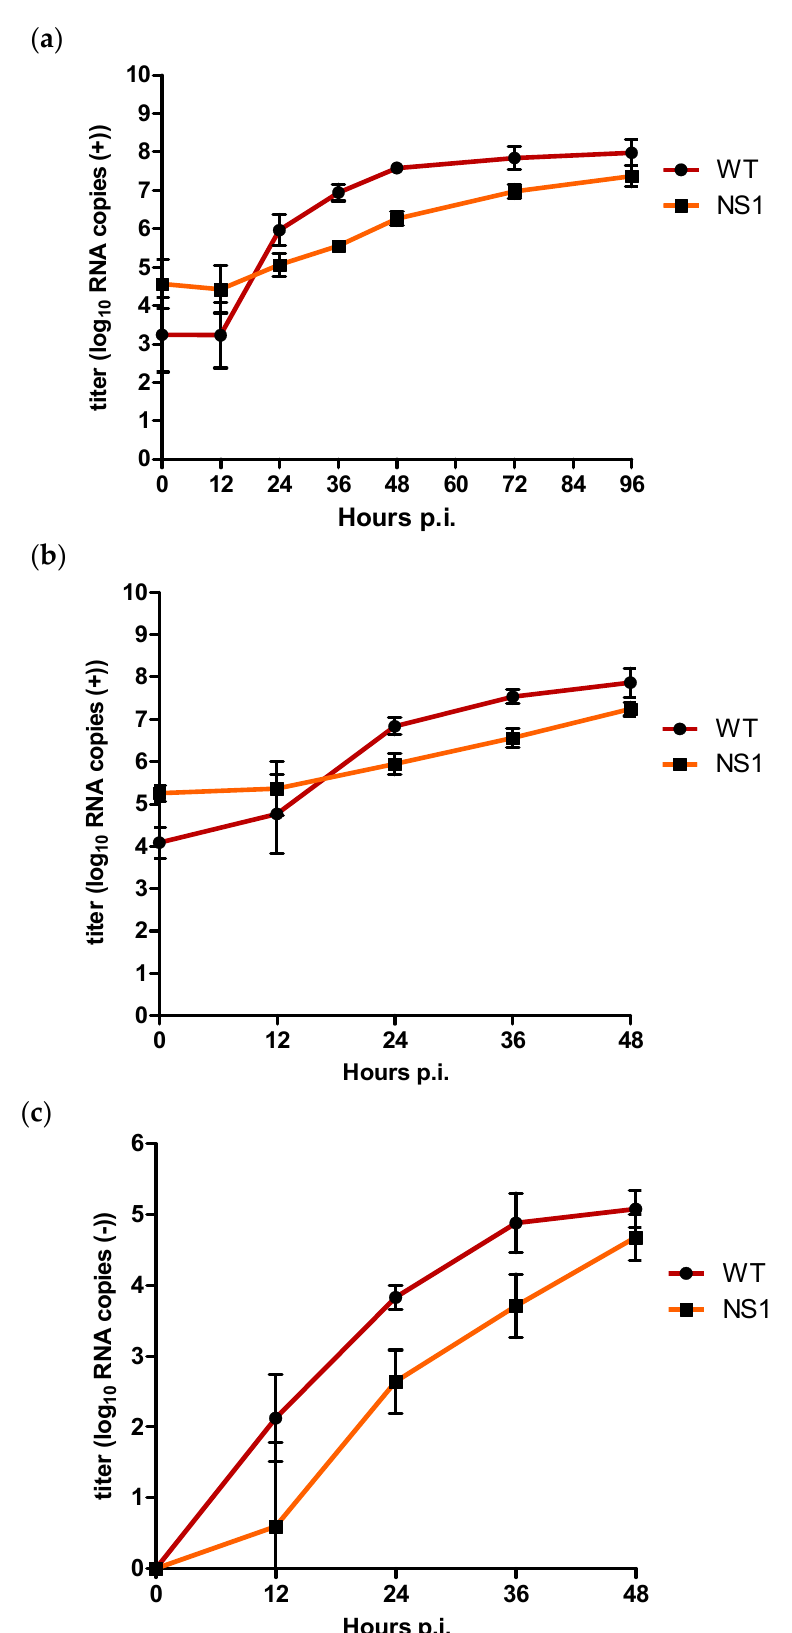
Figure 3. Quantification of ( a ) extracellular positive strand RNA ( b ) intracellular positive strand RNA, and ( c ) negative strand RNA for WT and NS1 mutant after triplicate infection of Vero E6 cells at an MOI of 0.1. Copy numbers are given as the mean of two independent experiments (log10 TCID 50 /mL); error bars represent standard deviation.